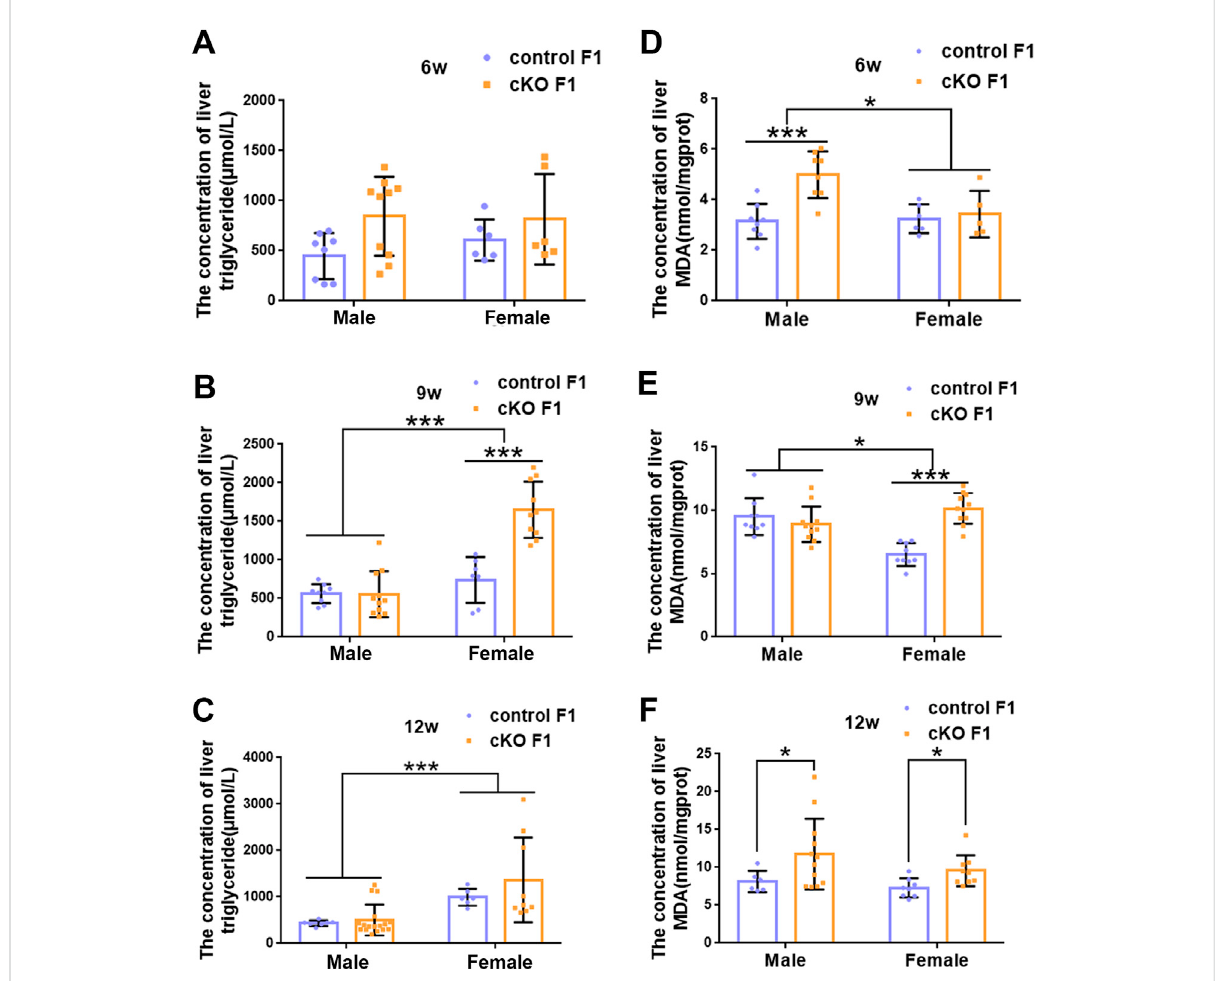
FIGURE 6 The concentration of liver lipid was measured in F1 generation of endometrial DNMT3B conditional knockout female mice (A – C) The concentration of liver triglyceride was measured in control and cKO F1 male (n = 8 – 17) and female (n = 6 – 10) mice at 6-weeks, 9-weeks and 12- weeks of age. (D – F) The concentration of liver malondialdehyde was measured in control and cKO F1 male (n = 8 – 12) and female (n = 5 – 11) mice at 6-weeks, 9-weeks and 12-weeks of age. Results are presented as mean ± SEM. MDA, malondialdehyde. * p < 0.05, *** p <